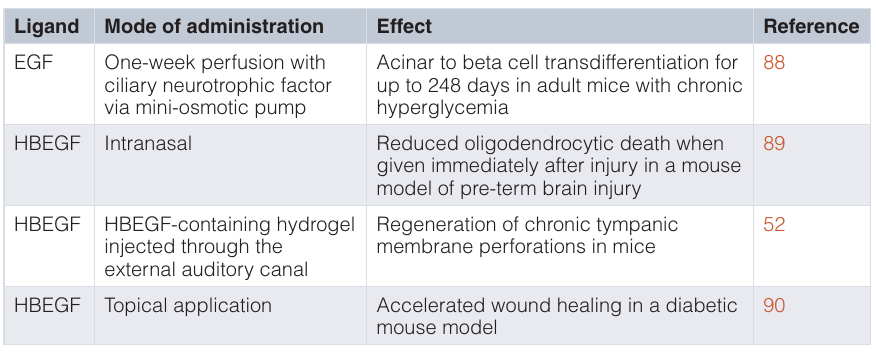
Table 1. In vivo administration of epidermal growth factor receptor ligands as treatment